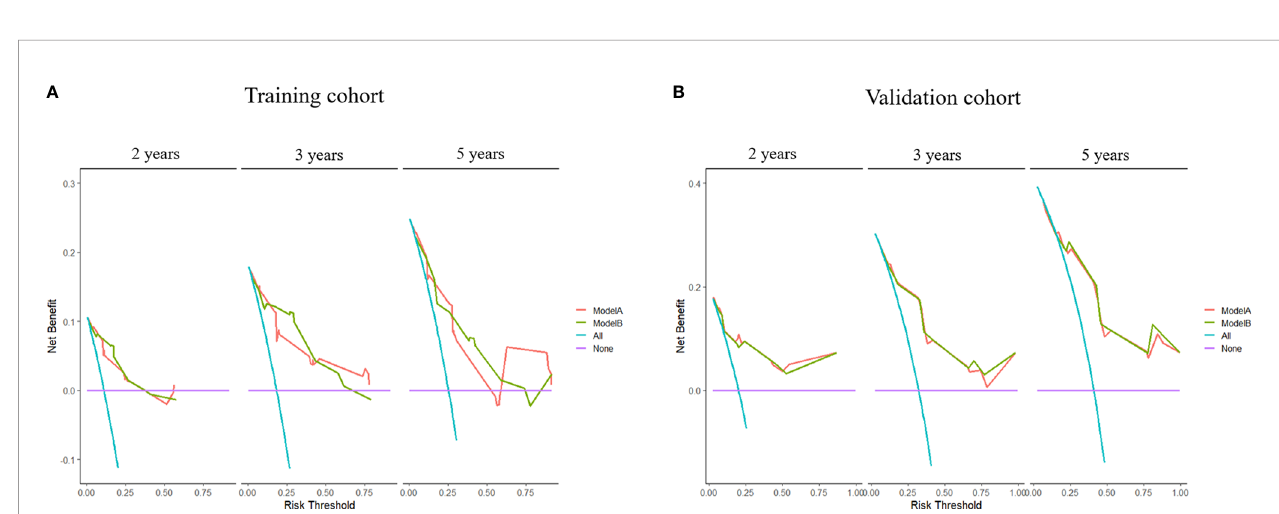
FIGURE 2 | Time-dependent receiver operating characteristic (ROC) curve of models (A, B) in the training and validation cohorts.